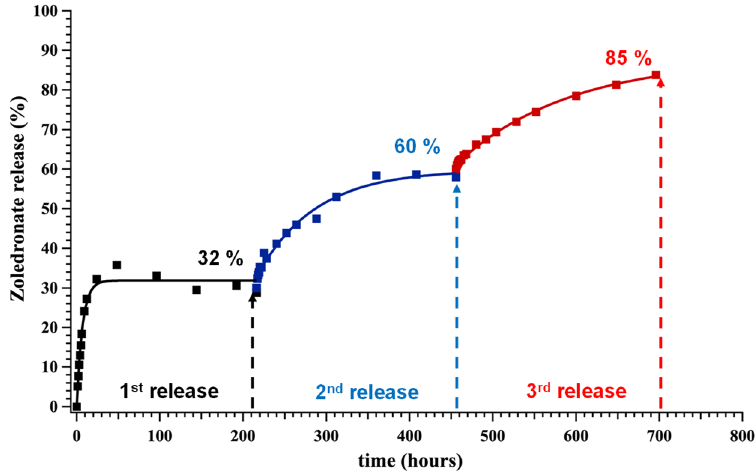
Figure 6. Cumulative, step-wise release of ZOL from the “free” ZOL system.